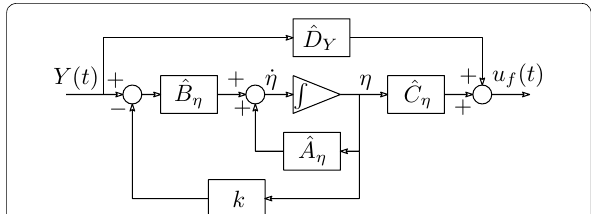
Fig. 6 Block diagram of the inverse system. This figure presents the state space Eqs. (12) and (13) as a control system block diagram